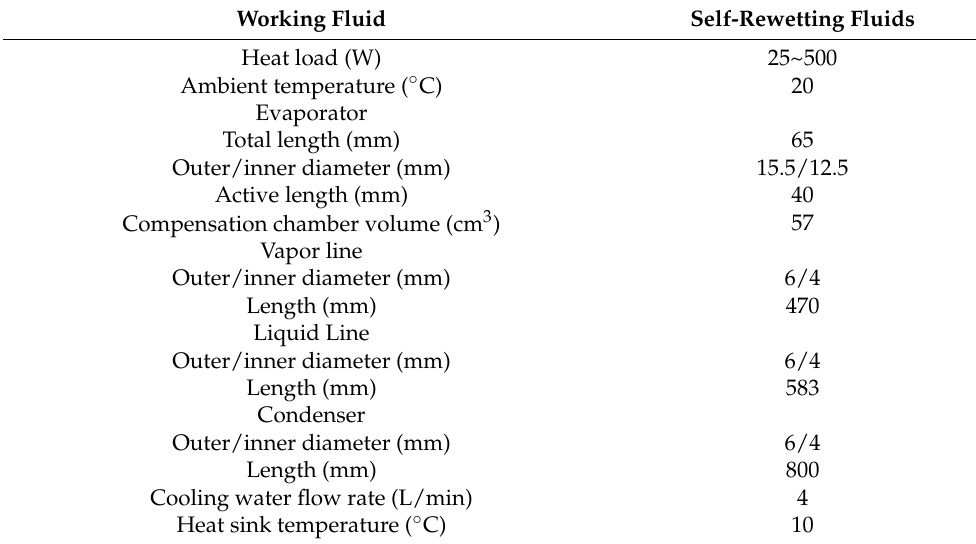
Table 1. LHP system parameters.